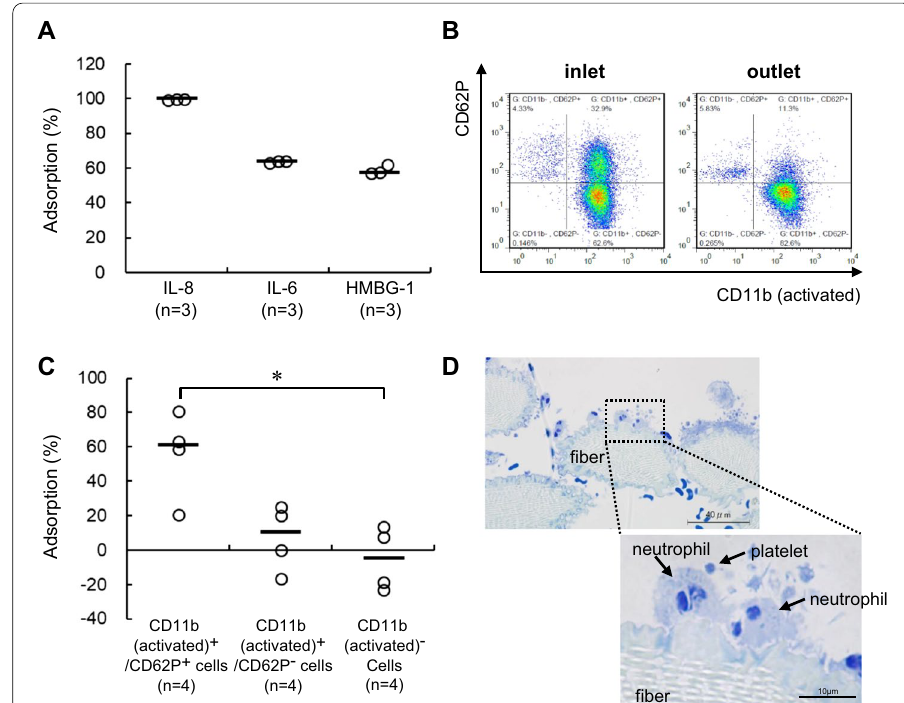
Fig. 1 In vitro adsorption of cytokines and inflammatory cells. a Adsorption rates of IL-8, IL-6 and HMGB-1. b Representative scatter plot at the inlet and outlet of the column in flow cytometry. c Adsorption rate calculated from flow cytometric analysis. d Toluidine blue staining of fiber after contact with activated human blood. Arrows indicate NPC. Data are shown as medians ( n 3 or 4) and an open circle indicates the = individual value. * p < 0.05 for CD11b (activated) + /CD62P + cells vs. CD11b (activated) − cells by